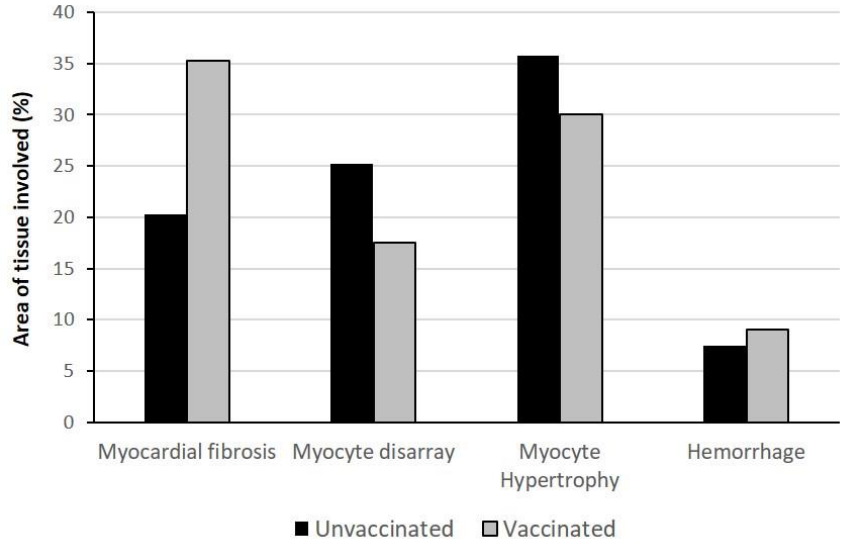
Figure 3. Histology score of heart damage in unvaccinated and vaccinated COVID-19 patients. Histological score of myocardial injury determined by the percentage of the tissue area involved. A trend towards more severe fibrotic damage is present in vaccinated patients.